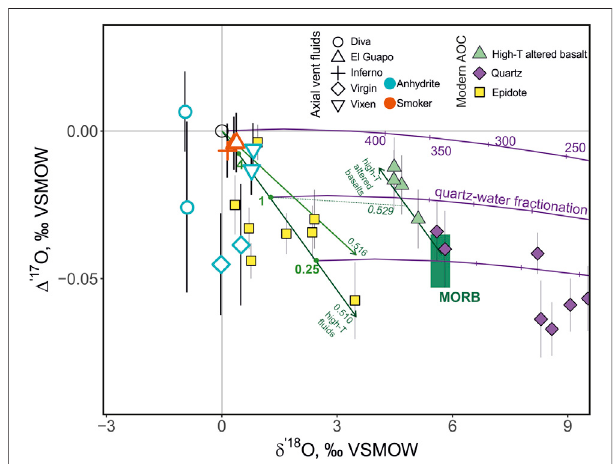
FIGURE 4 | Triple oxygen isotope systematics of submarine vent fl uids, oceanic quartz, epidote and high temperature altered basalts. The data is assembled from previous publications (altered basalts from Sengupta and Pack, 2018 and Zakharov and Bindeman, 2019; oceanic and quartz fromZakharovandBindeman,2019;Zakharovetal.,2019)andreducedfora better comparison as recently proposed in Herwartz (2021). The trajectory of high-temperature reaction between seawater and mid-ocean ridge basalt (shown as MORB) is shown with the two green arrows along the slopes of 0.510 and 0.516 for the fl uids and along the slope of 0.510 for the high- temperature altered basalts (slopes are in δ ′ 17 O- δ ′ 18 O coordinates). Dots on the line correspond to W/R of 4, 1, 0.25. Equilibrium between fl uids and altered basalts at W/R (cid:1) 1 isshown withadotted linewith theslope of0.529. The quartz-water equilibrium fractionation (equation after Wostbrock et al., 2018) at temperatures between 250 and 400 ° C is shown.